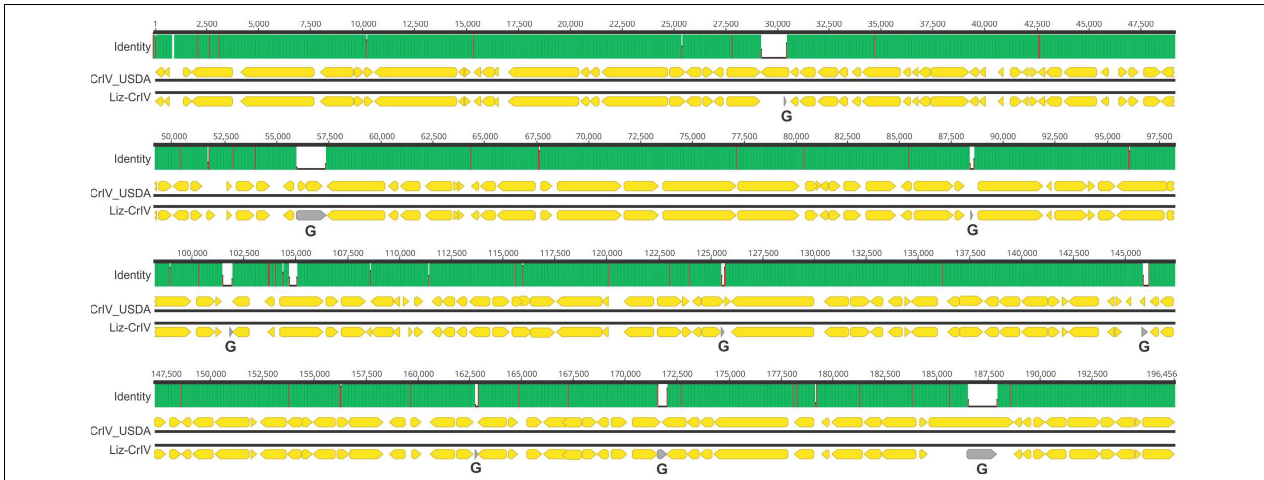
FIGURE 3 | Schematic showing a genome-wide pairwise comparison between CrIV_USDA and lizard–cricket iridescent virus (Liz-CrIV). Each block, including “Identity,” “CrIV_USDA,” and “Liz-Cr-IV,” illustrates the shared identity and organization for each genome, respectively. The numbers at the top each block indicate alignment positions. The “Identity” panel highlights identical sites (green), mismatches (red), and gaps (white) across the alignment. Non-overlapping open reading frames encoding putative proteins larger than 80 amino acids in each genome are highlighted with yellow arrows. Areas of the Liz-CrIV genome annotated as gaps (G) in GenBank are highlighted with gray